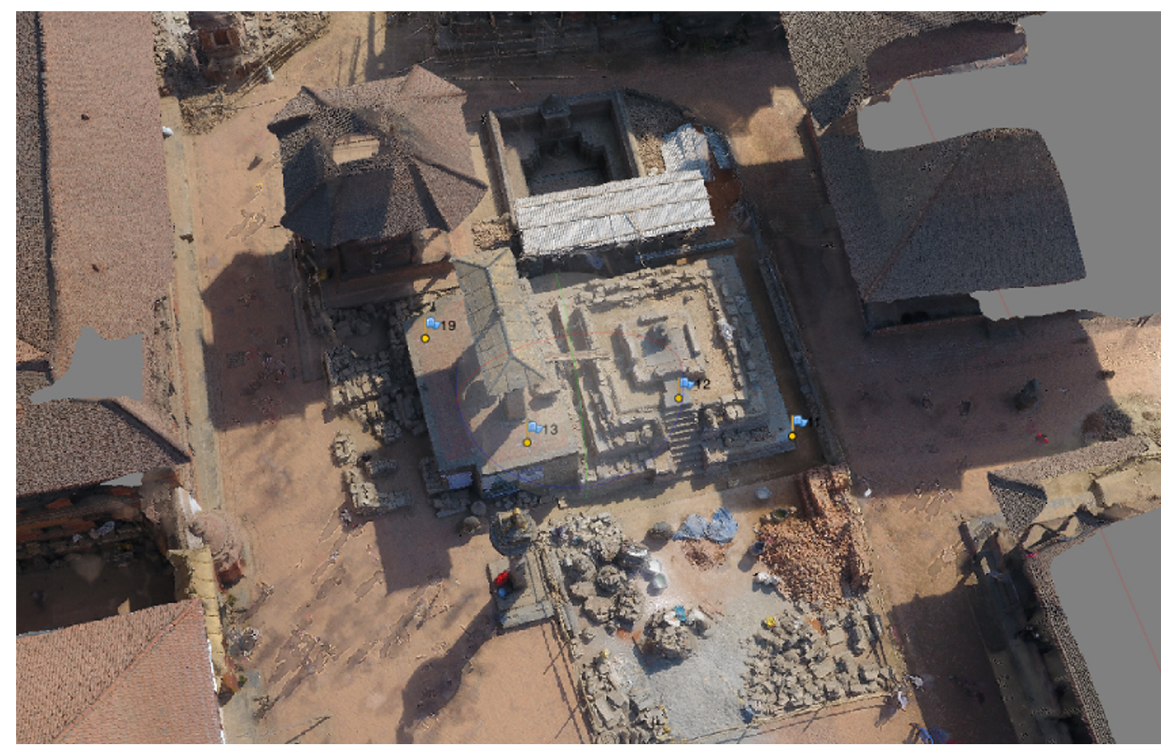
Fig. 8 Ortho-corrected image from aerial photogrammetry of the Bhaktapur Durbar Square after the earthquake (2017) (Source: the